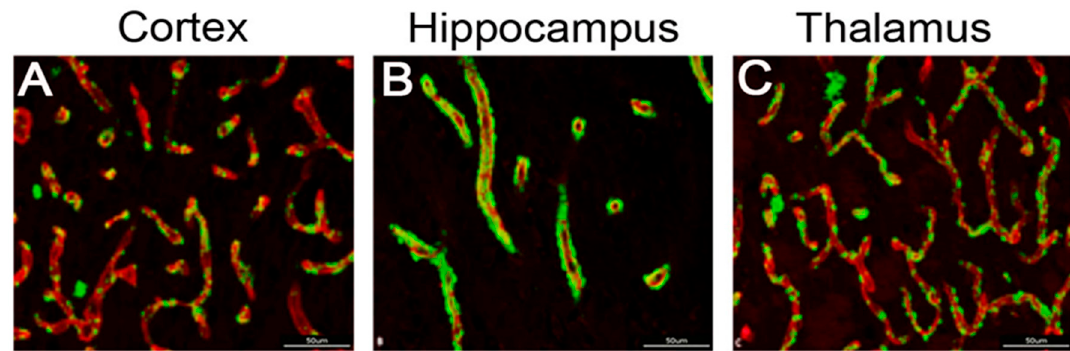
Figure 11. Cerebral microvascular amyloid accumulation in rTg-DI rats was unaffected by operant training. Representative brain sections from 12-month-old rTg-DI rats at the completion of operant training and behavioral analysis that were stained with thioflavin S to identify fibrillar microvascular amyloid (green) and immunolabeled with an antibody to collagen IV to identify cerebral blood vessels (red). Robust microvascular amyloid deposits are observed in the cortex ( A ) hippocampus ( B ) and thalamus ( C ). Scale bars = 50 µm.